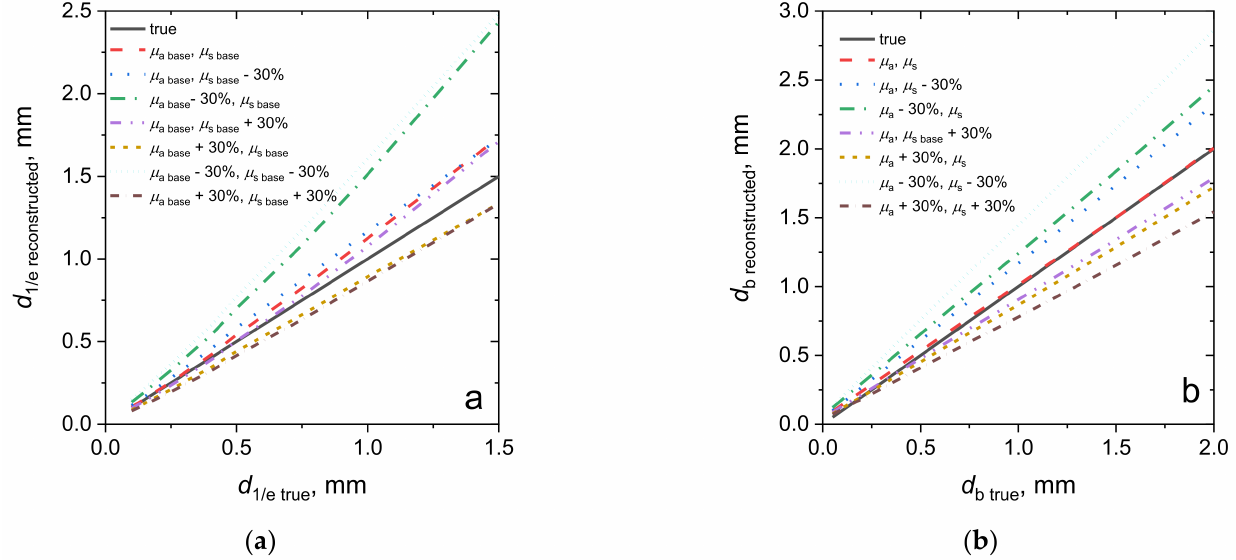
Figure 6. Reconstructed values of the fluorophore localization depth versus the true localization depth, depending on the medium optical properties employed for the reconstruction for cases of topical PS administration ( a ) and intravenous injection ( b